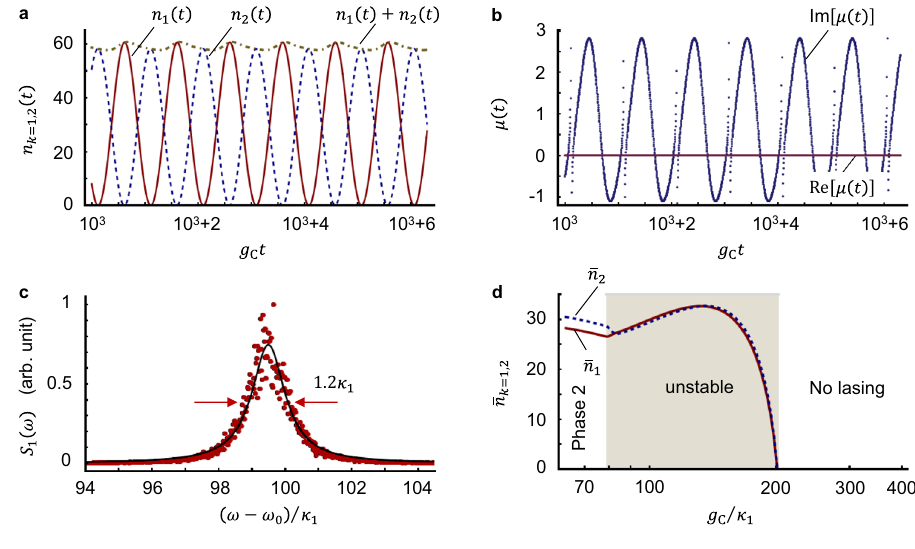
Fig. 3 Unstable lasing dynamics. a Time-dependent intensities of two cavity fi elds n k ¼ 1 ; 2 t ð Þ with the intercavity coupling strength g C = κ 1 ¼ 99. Here, k ¼ 1 ; 2 denote the cavities 1 and 2, respectively, and the photon loss rate κ 1 of cavity 1 is chosen as the frequency unit in the plot. Both n k ¼ 1 ; 2 t ð Þ vary periodically with a period of about g (cid:2) 1 . b Time evolution of the diagonal element μ t ð Þ of the Hamiltonian H t ð Þ with g C = κ 1 ¼ 99. The real part of μ t ð Þ C maintains at zero, while its imaginary part varies periodically and diverges within a short duration around n 1 t ð Þ (cid:4) 0. c Numerical simulation of the emission spectrum S 1 ω ð Þ of cavity fi eld 1 (red fi lled circles) with g C = κ 1 ¼ 99. Here, ω denotes the angular frequency in the frequency domain and ω 0 is the central frequency of the laser transition. Only the spectral section on the blue-detuned side is presented and its mirror image gives the spectral section on the red- detuned side. The solid line corresponds to the curve fi tting. The spectrum S 2 ω ð Þ of cavity fi eld 2 shows a nearly identical line shape. d Time-averaged R t ¼ 1 intracavity intensities (cid:1) n n t ð Þ d t with an arbitrary initial time t and a time duration Δ t (cid:4) g (cid:2) 1 vs. the intercavity coupling strength g . In 0 þ Δ t t Δ t k ¼ 1 ; 2 k ¼ 1 ; 2 0 C C 0